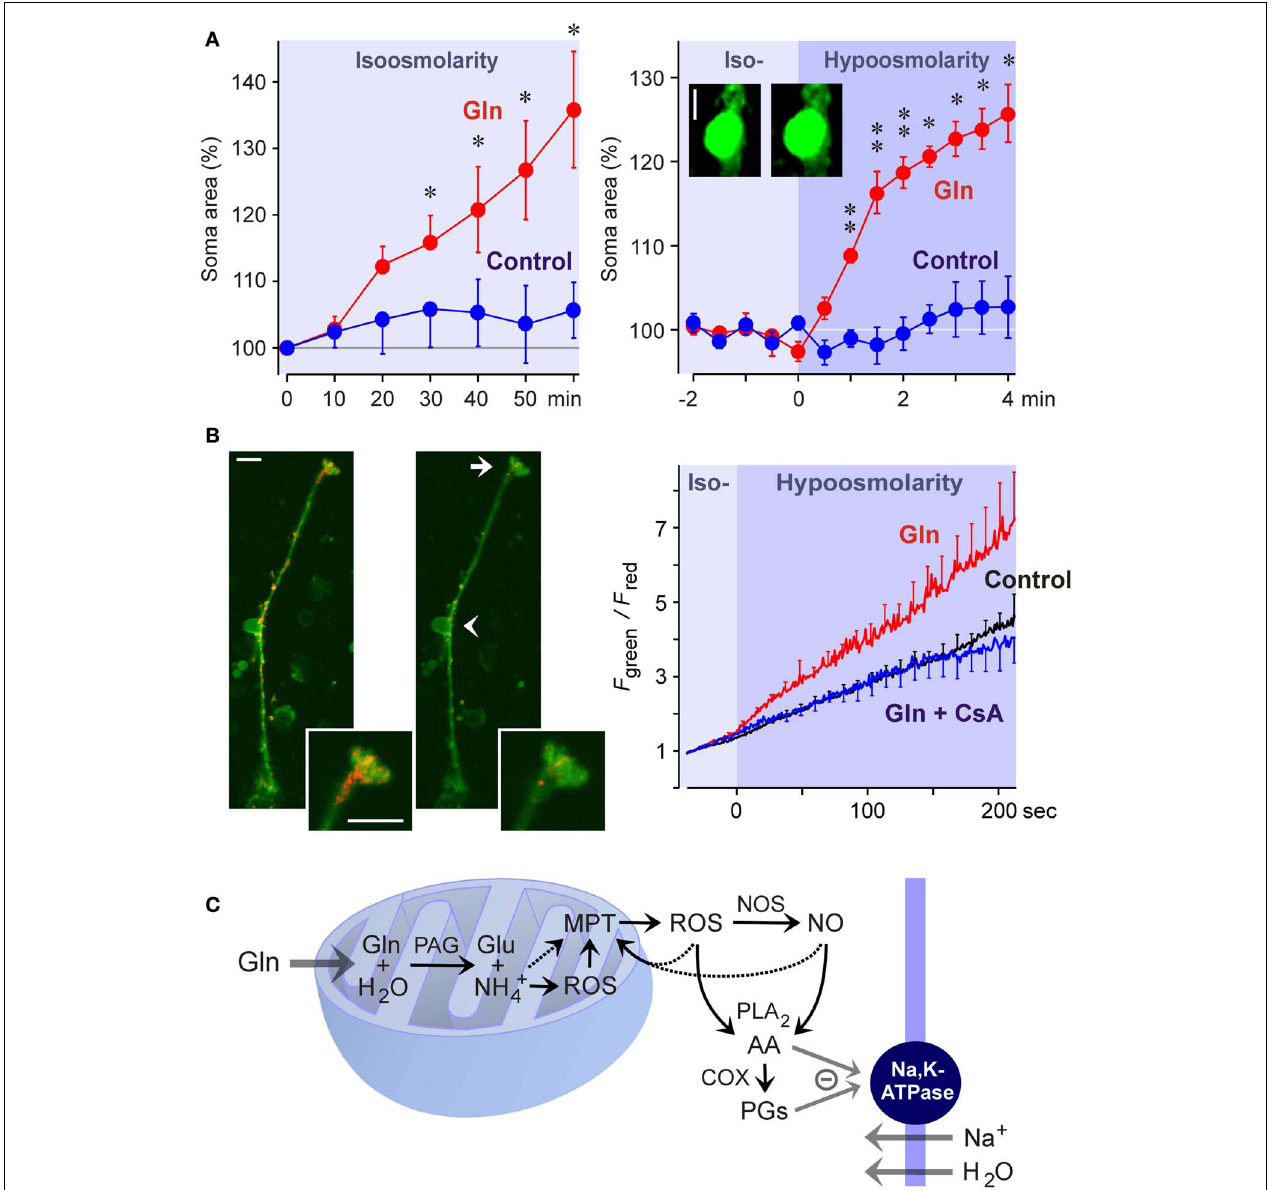
Left side: Example of a JC-1-loaded cell which was recorded before ( left ) and during ( right ) superfusion of a hypoosmotic solution containing glutamine (5mM). Insets , cell endfoot at higher magnification. Note the decrease in the red fluorescence. Arrow , cell endfoot. Arrowhead , cell soma. Bars, 10 µ m. Right: Time-dependent change in the ratio of the green-to-red fluorescence of the JC-1 dye.The fluorescence was recorded in the absence and presence of glutamine (5mM), before and during the transition of an isoosmotic to a hypoosmotic extracellular solution. Glutamine-induced a faster dissipation of the mitochondrial membrane potential as compared to control.The inhibitor of the mitochondrial permeability transition, cyclosporin A (CsA; 1 µ M), prevented the glutamine-induced dissipation of the mitochondrial potential. (C) Hypothetical scheme of the mechanism of glutamine-induced Müller cell swelling. Cytosolic glutamine is transported into the mitochondria and is hydrolyzed there to glutamate (Glu) and ) by the action of the phosphate-activated glutaminase (PAG). ammonia ( NH + 4